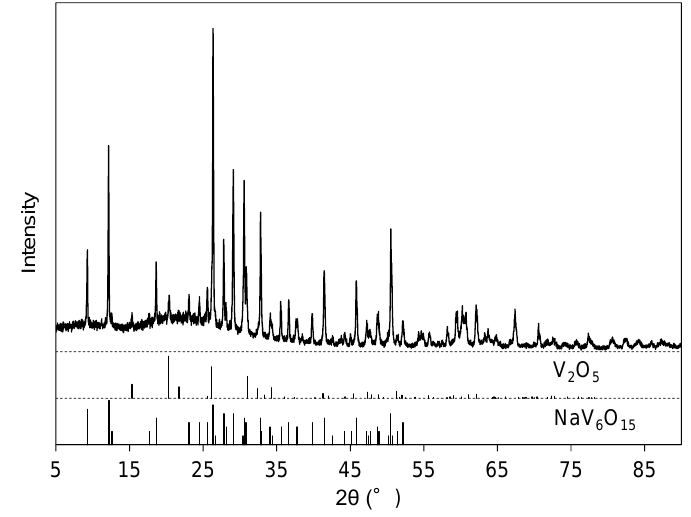
Figure 6. XRD pattern of Precipitate C after heat treatment at 500 °C for 1 h.